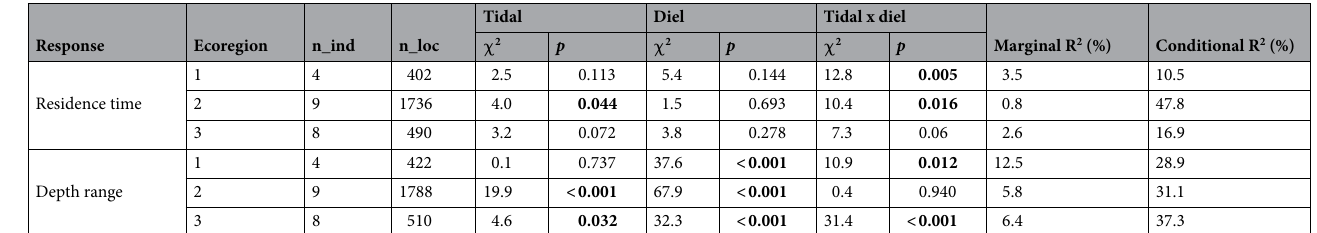
Table 4. Summary of the linear mixed model relating residence time or used depth range with tidal (high/ low) and diel phase (dawn/day/dusk/night). The number of individual dugongs and locations contributing is reported by ecoregion (n_ind and n_loc respectively). Type III Wald χ 2 tests are computed for each model ( χ 2 statistic and p value reported). Significant relationships ( p value < 0.05*) are shown in